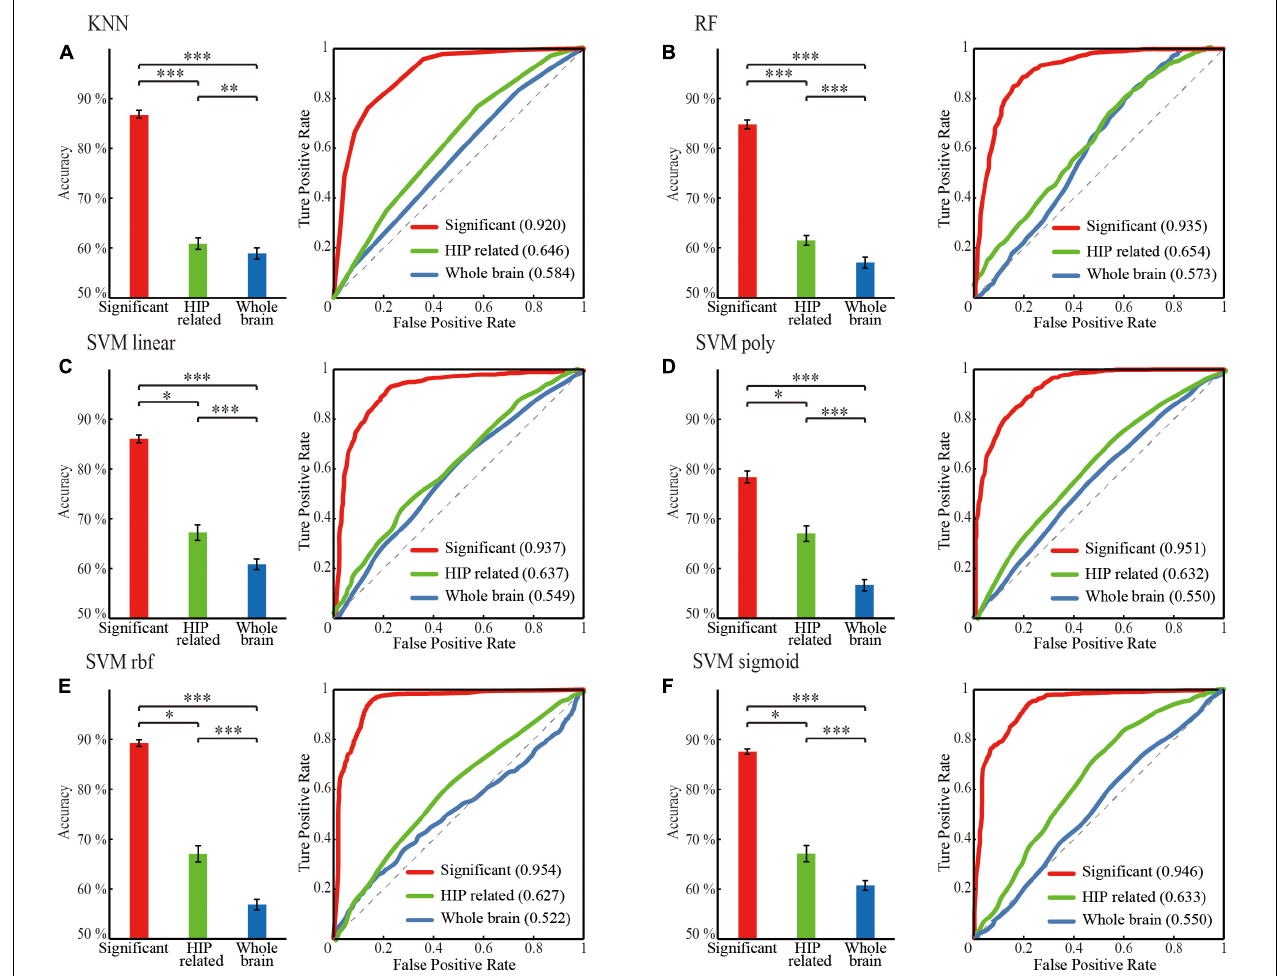
FIGURE 3 | Classification performance comparison between different mean diffusivity (MD) feature sets for different classifier. (A) KNN. (B) RF. (C) SVM linear. (D) SVM poly. (E) SVM rbf. (F) SVM sigmoid. ‘red’: the significant HIP related WM network; ‘green’: HIP related WM network; ‘blue’: the whole brain WM network. Classification performance including mean accuracy (mean ± std; * p < 0.05, ** p < 0.005, and *** p < 0.0005; ranksum test with bonferroni correction) and AUC of randomly 100 times hold out method.